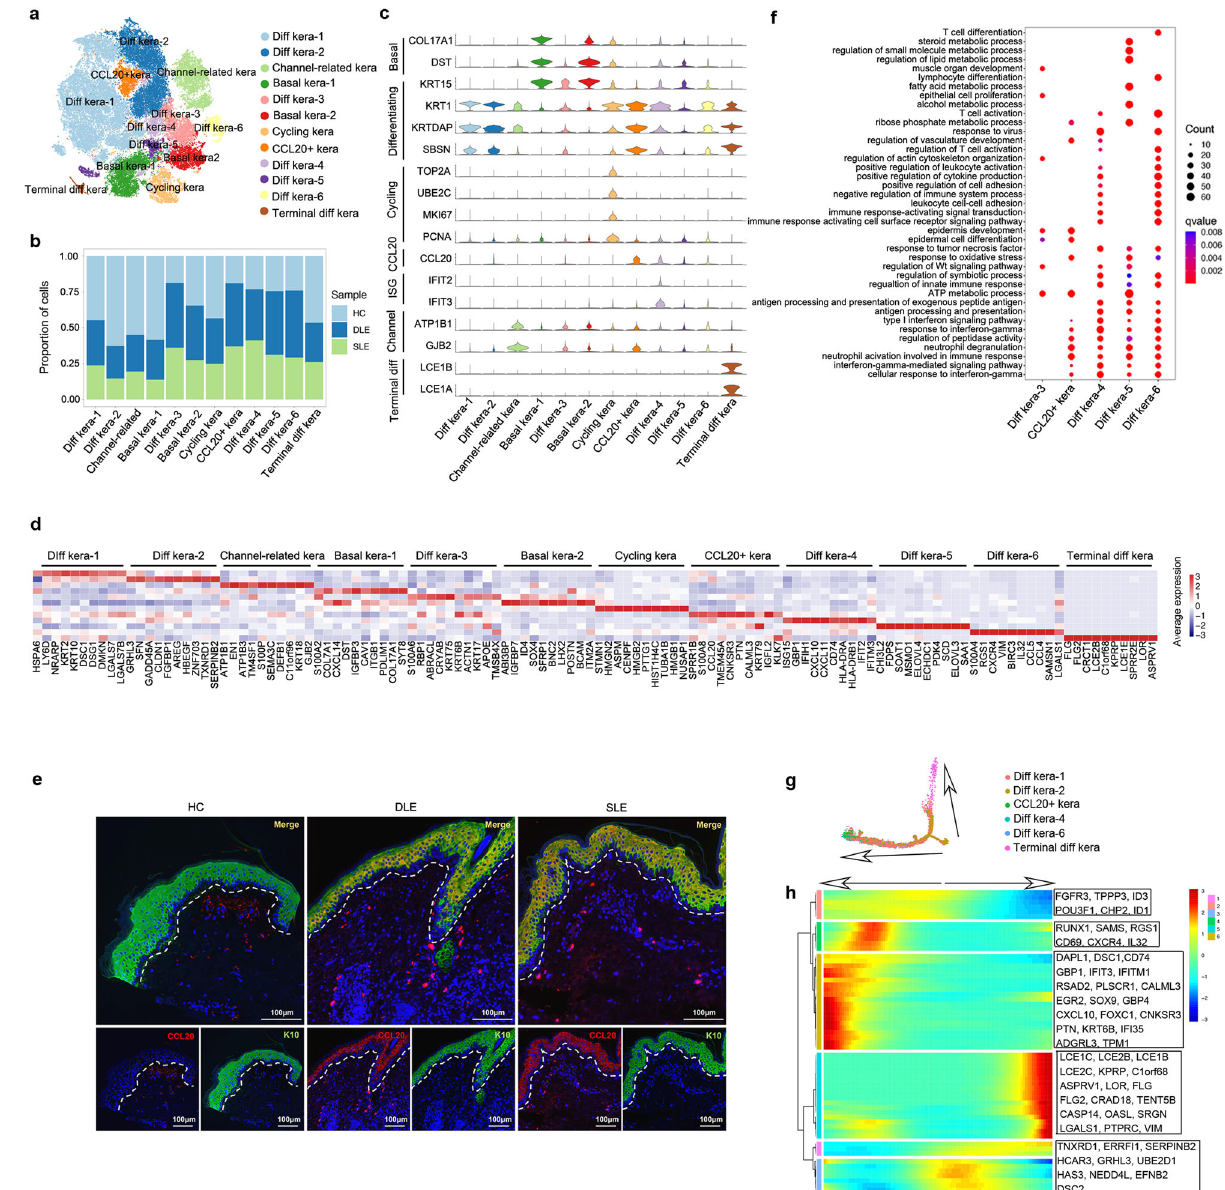
Fig. 3 | Sub-clustering analysis of keratinocytes identi fi es major keratinocyte subtypes in epidermis. a t-SNE plot represents subtypes of keratinocytes merged from HC, DLE and SLE by Seurat packages. Diff kera-1 – 6: differentiating keratino- cyte subtype 1 – 6; Basal kera-1, 2: basal keratinocyte subtype 1, 2; Channel-related kera:channel-relatedkeratinocyte;Cyclingkera:cyclingkeratinocyte;CCL20 + kera: CCL20 + keratinocyte subtype; Terminal diff kera: terminally differentiating kerati- nocyte subtype. b A bar plot shows the cell proportions of each sample group in labeled keratinocyte subtypes. c Stacked violin plots represents the expression levels of the selected genes used for de fi ning keratinocyte subtypes. d A heatmap displaysthetop10differentiallyexpressedgenesineachsubtypeofkeratinocytes. e Immuno fl uorescence staining represents the expression of CCL20 (red) and